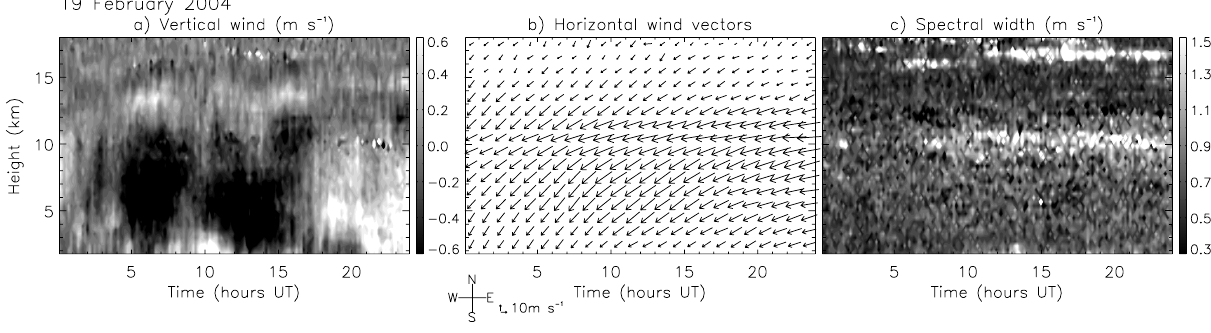
Fig. 6. (a) NOAA AVHRR image at 14:10 UT, and (b) higher-resolution MODIS image at 13:20 UT, 19 February 2004. (a) is visible channel 2, (b) false colour.